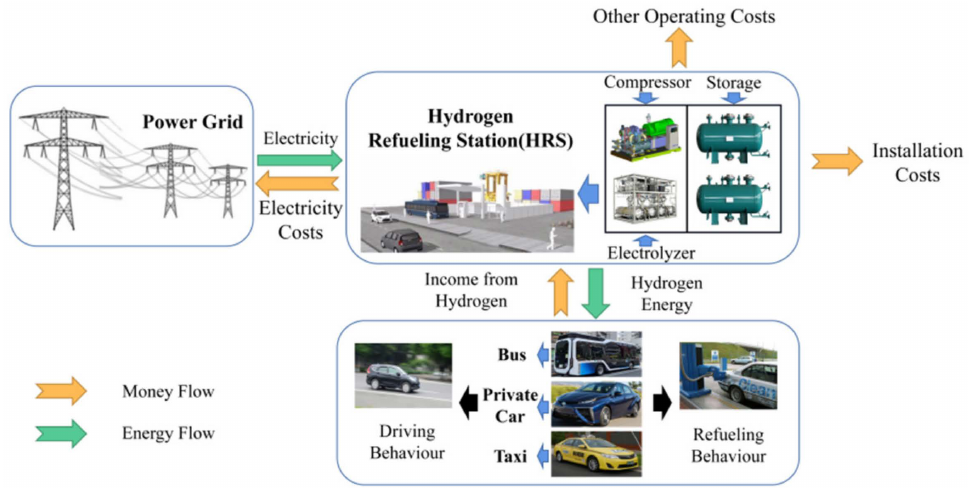
Figure 2. HRS scenario of the case study.